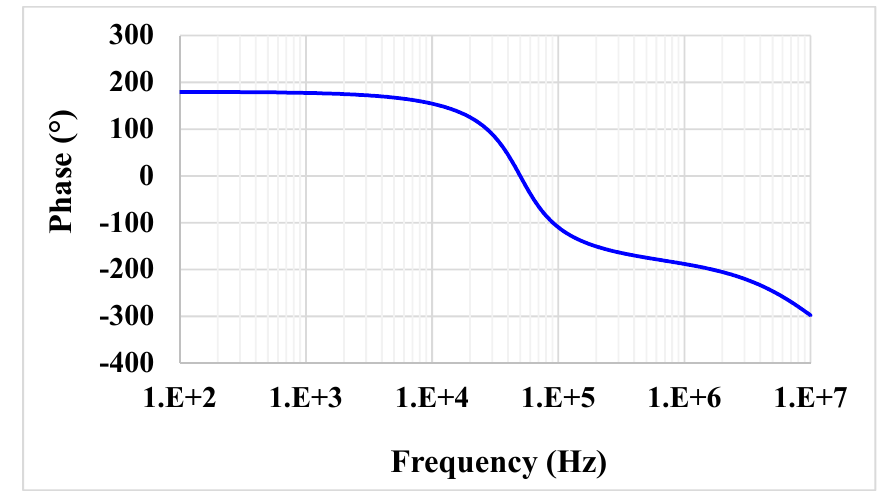
Figure 10. Phase characteristics of the all-pass (AP) filter.